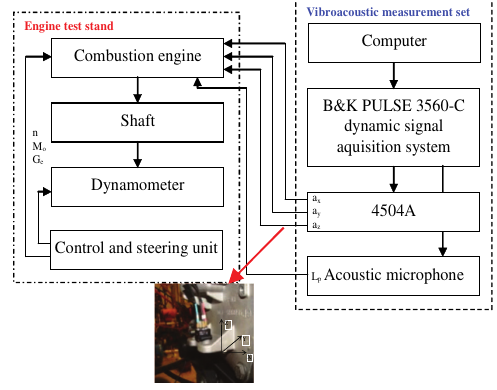
Fig. 2. The functional scheme of the measurement test